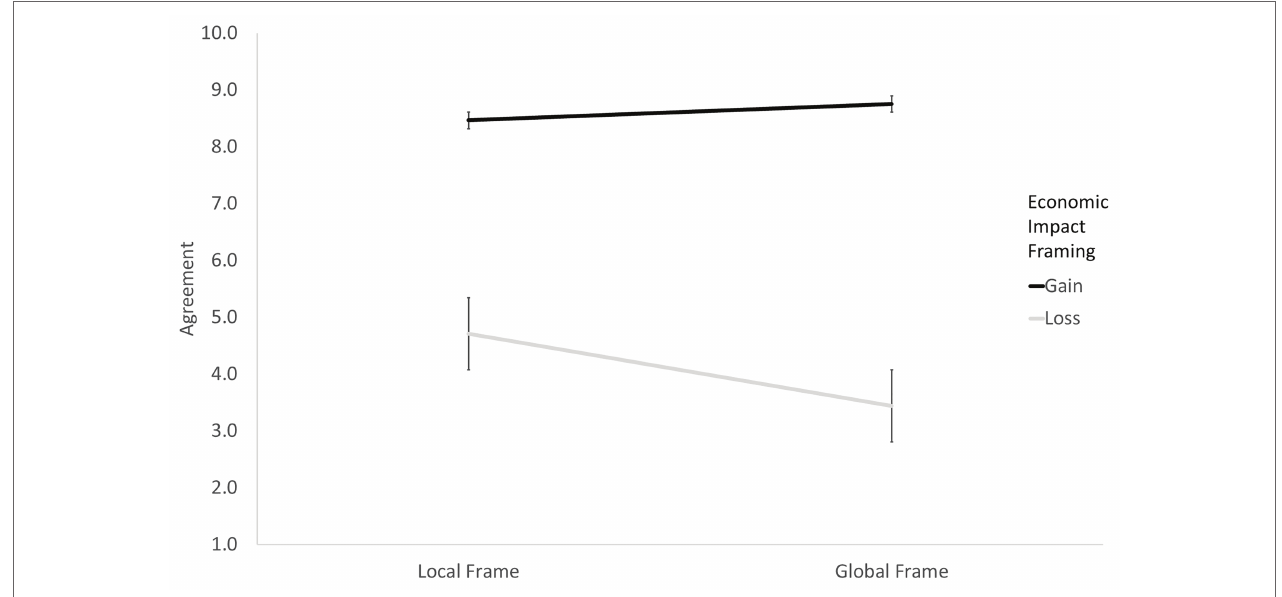
FIGURE 1 | Agreement with gain vs. loss messages on the economic impact of the policy as a function of local vs. global framing (Study